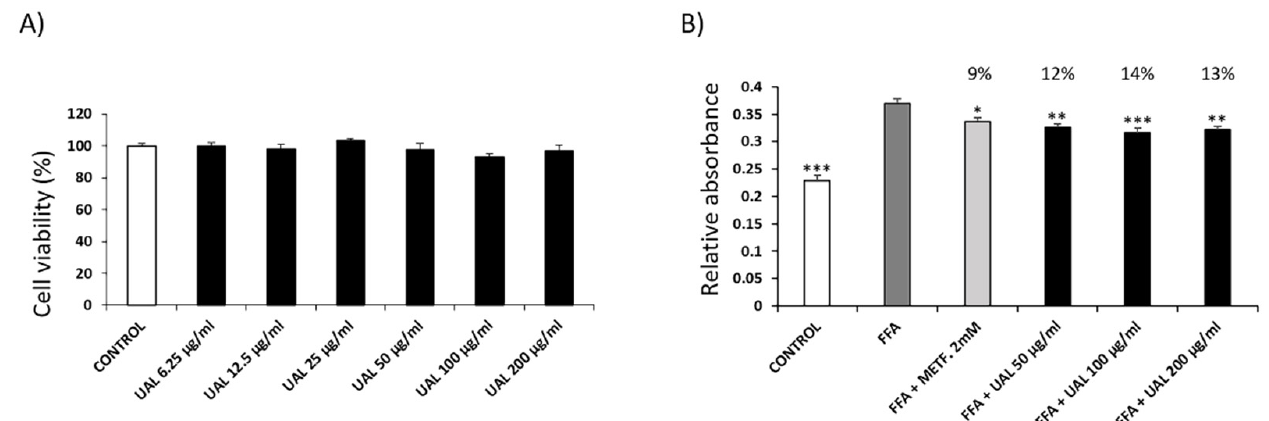
Figure 3. Effect of UAL on cell viability and lipid accumulation in HepG2 hepatocytes. ( A ) HepG2 cells were treated with various doses (0–200 µ g/mL) of UAL. Cell viability was measured by the MTT assay after 72 h of treatment. Values are expressed as mean ± SEM of three independent experiments each one performed in triplicate. ( B ) HepG2 cells were loaded with FFAs (oleic acid:palmitic acid/2:1) and treated with UAL for 72 h. Metformin was used as positive control. HepG2 cells were stained with oil red and lipid accumulation was quantified. Values are expressed as mean ± SEM of four independent experiments each one performed in triplicate. * p < 0.05, ** p < 0.05, *** p < 0.001 compared with FFA group (ANOVA with Dunnett ´ s post hoc test).